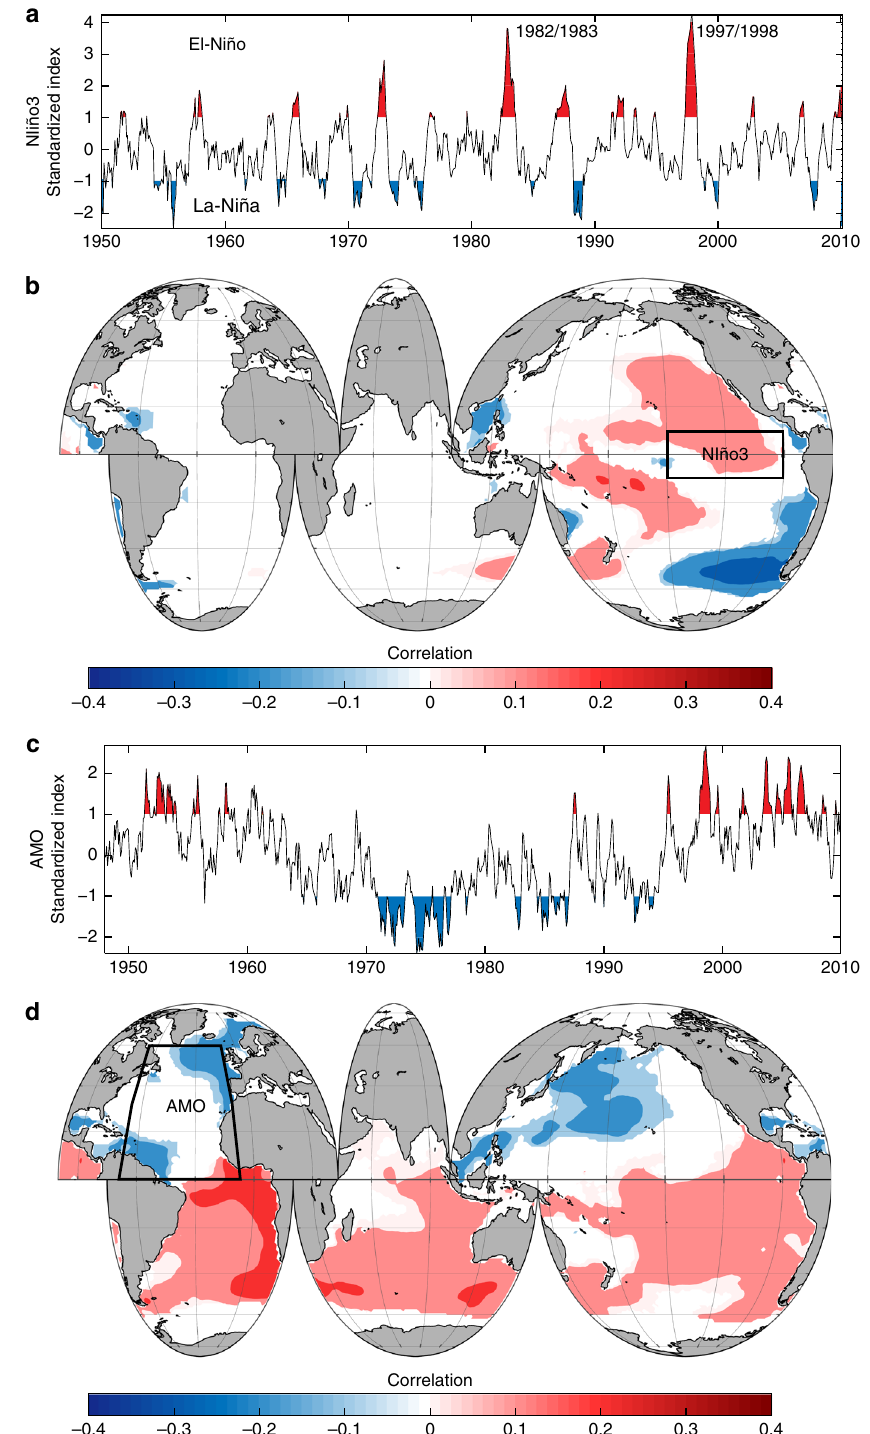
Fig. 7 In fl uence of Sea Surface Temperature climate indices on Wave Power. a Time series of Niño3 standardized index; b spatial correlation pattern of Niño3 with Wave Power; c time series of the AMO standardized index; and d spatial correlation pattern of the Atlantic Multidecadal Oscillation (AMO) with Wave Power. The Niño3 index registers Sea Surface Temperature anomalies in the tropical Paci fi c (90°-150ºW, 5ºS-5ºN). The red and blue colored areas in a and c represent moderate or above events (with absolute value of index of 1 or above) for each corresponding climate index. For the correlation maps b and d , only the linear correlations that are signi fi cant at the 95% level are shown. The polygons represented in the maps in b and d identify the areas in which each index is calculated based on Sea Surface Temperature anomalies (see